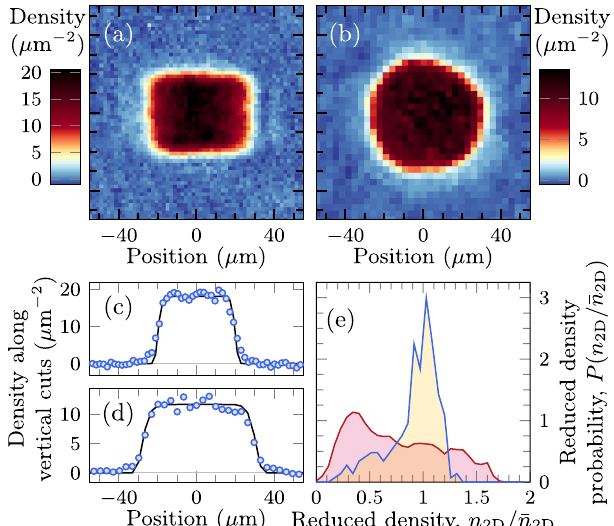
FIG. 9. In situ density analysis. An example of an in situ atomic density measured by absorption imaging from the side (a) and from the top (b) (the cylinder symmetry axis is vertical). Vertical cuts along the side and top images (circles) together with a fit to the numerical model (solid lines) are shown in insets (c) and (d), respectively. The flat part of the cut is where the density is uniform. Inset (e) shows a 2D density probability distribution of the flat trap (blue line) and a harmonically trapped gas (red line). The density probability function of the flat trap is peaked around the average density value, indicating that most of the density is close to the average. (a) and (b) are an average of five and ten experimental repetitions,